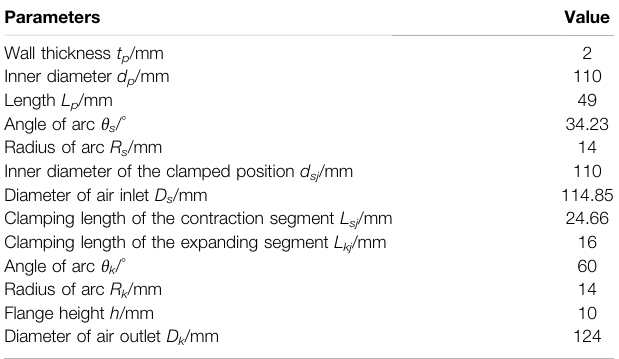
TABLE 2 | Geometric parameters of the contraction segment. Parameters